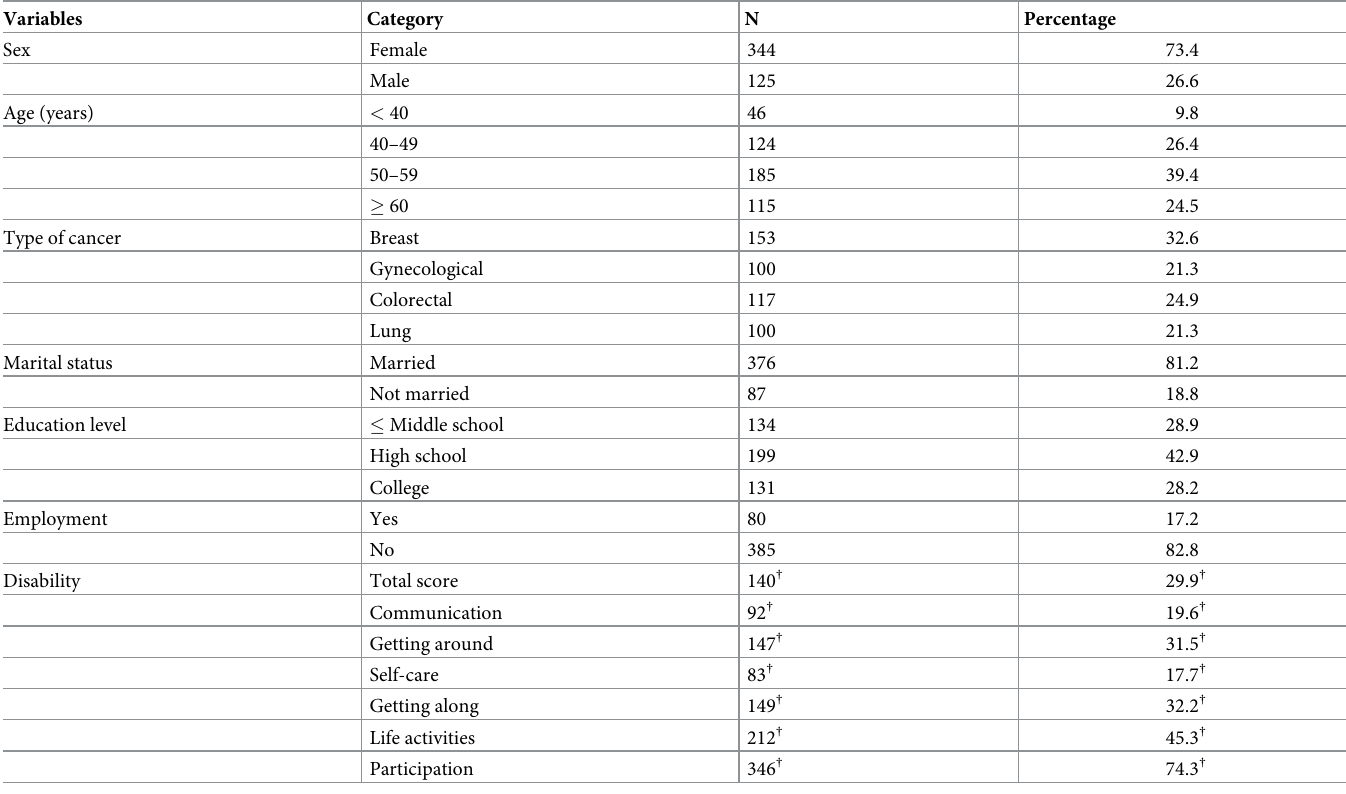
Table 1. Demographic characteristics of study participants.